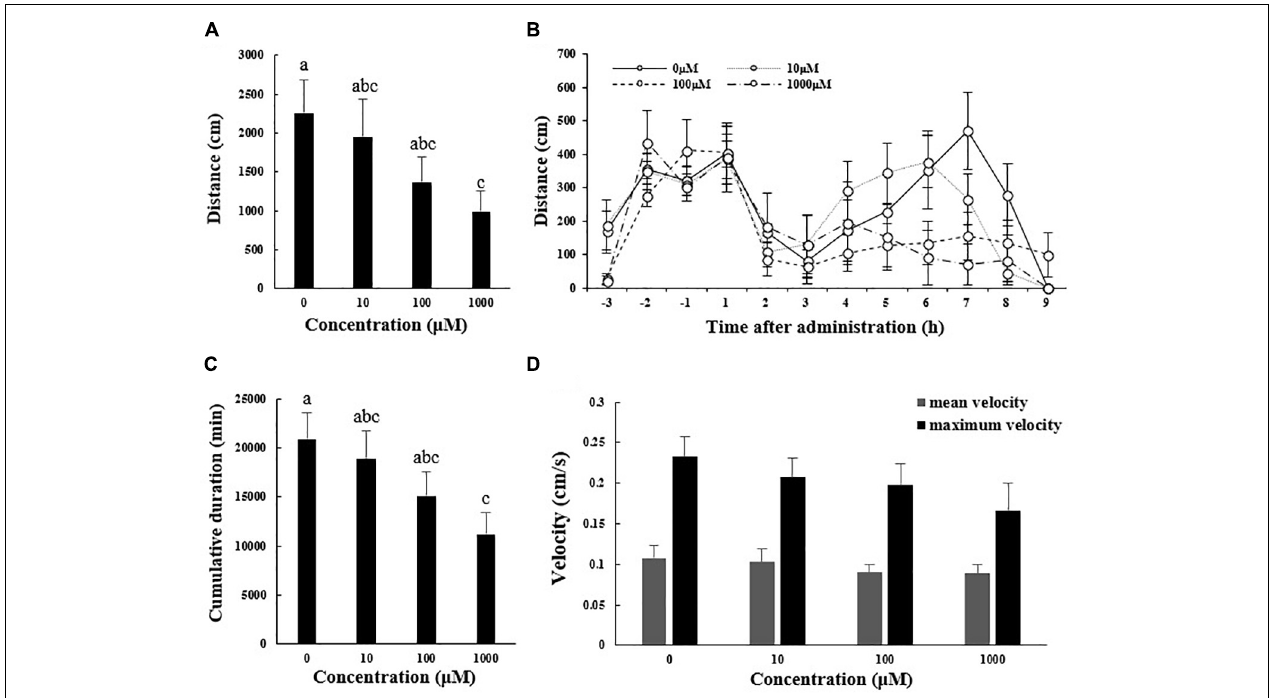
FIGURE 1 | Total distance traveled (A) , cumulative duration of movement (C) , and mean and maximum velocity (D) for A. japonicus in the different treatment groups 9 h after intraperitoneal injection with melatonin or the control and distances moved within each hour interval before and after injection with melatonin or the control (B) . Results are shown as the mean ± SEM. Different letters indicate significant differences ( N = 12, p < 0.05).